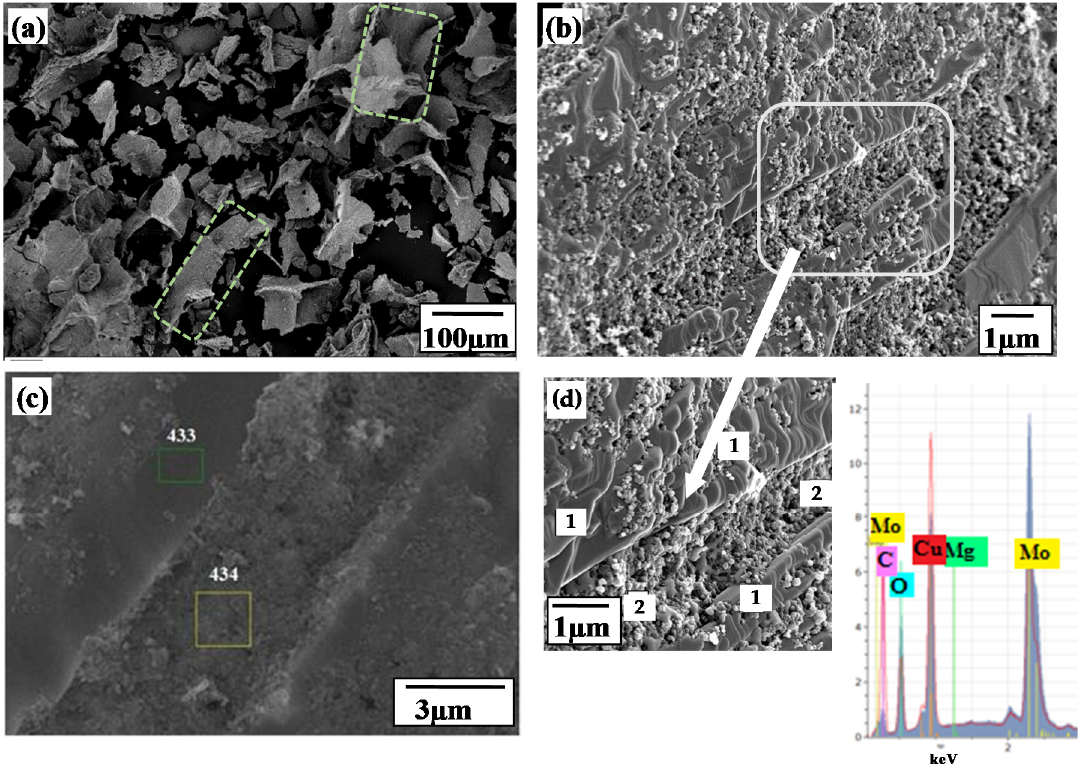
Figure 12. SEMmicrographs of the quenched sample at 873 K at different magnifications ( a – c ) and EDS spectra derived from area 1 (or 433—blue) and area 2 (or 434—red) ( d ) .